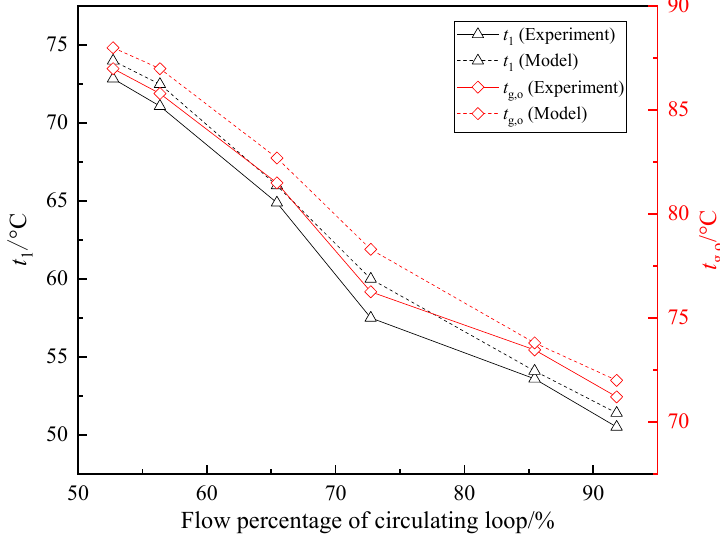
Figure 21. The measured t g,o and t 1 were also close to the temperatures calculated by the model. Figure 20. Relationship between β and t g,o , t 1 .